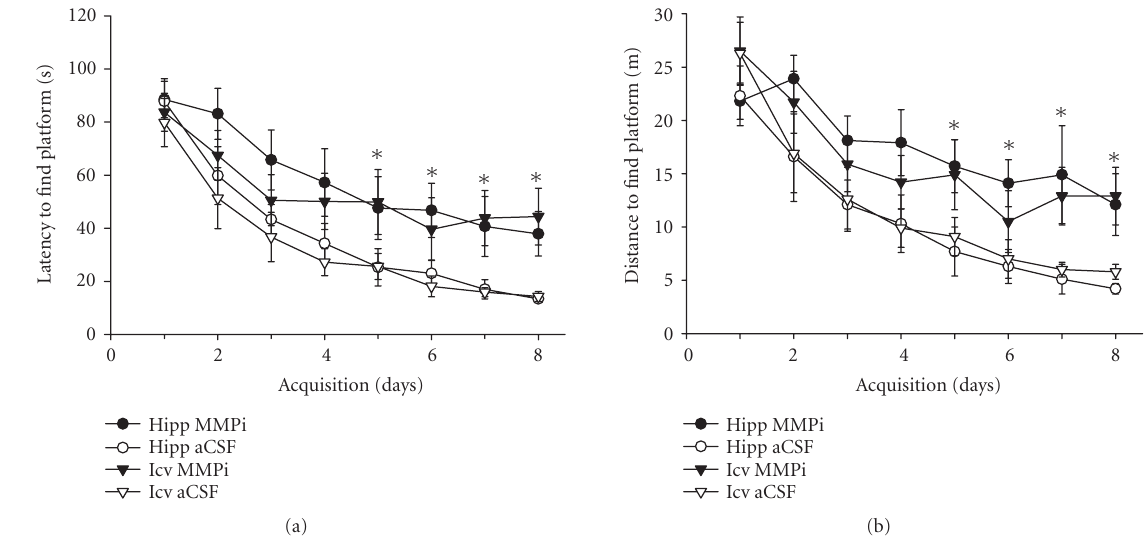
Figure 1: Mean SEM group changes in latencies (a) and distances (b) to locate the platform in the Morris water maze during 8 acquisition (cid:0) days. Five trials were administered per day with the location of the platform fixed during training for each animal. Bilateral injections of an MMP inhibitor (MMPi: FN-439) into dorsal hippocampi (Hipp) or intracerebroventricularly (icv) significantly interfered with the acquisition of the task. In contrast, bilateral injections of the vehicle, artificial cerebrospinal fluid (aCSF), into dorsal hippocampi or icv did not interfere with the acquisition of this task of spatial memory. Those groups injected with MMPi revealed significantly longer latencies to find the platform than the aCSF injected groups on days 5–8 of acquisition. (cid:0) P < .